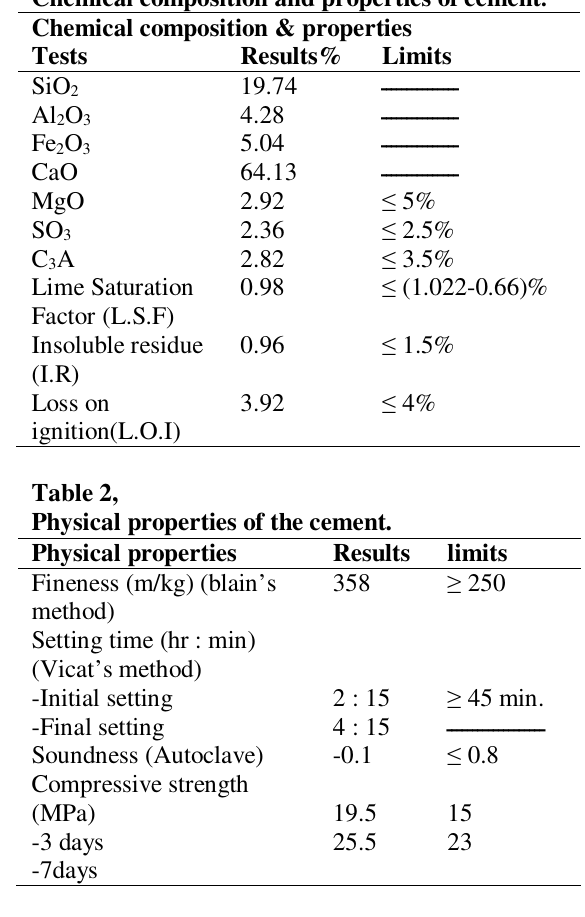
Chemical composition and properties of cement .